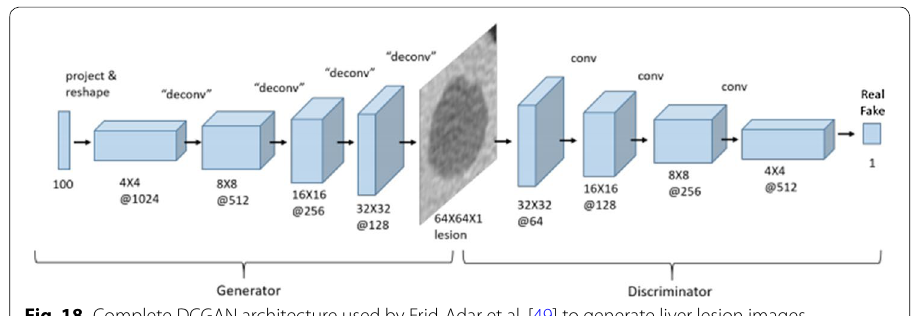
Fig. 18 Complete DCGAN architecture used by Frid-Adar et al. [49] to generate liver lesion